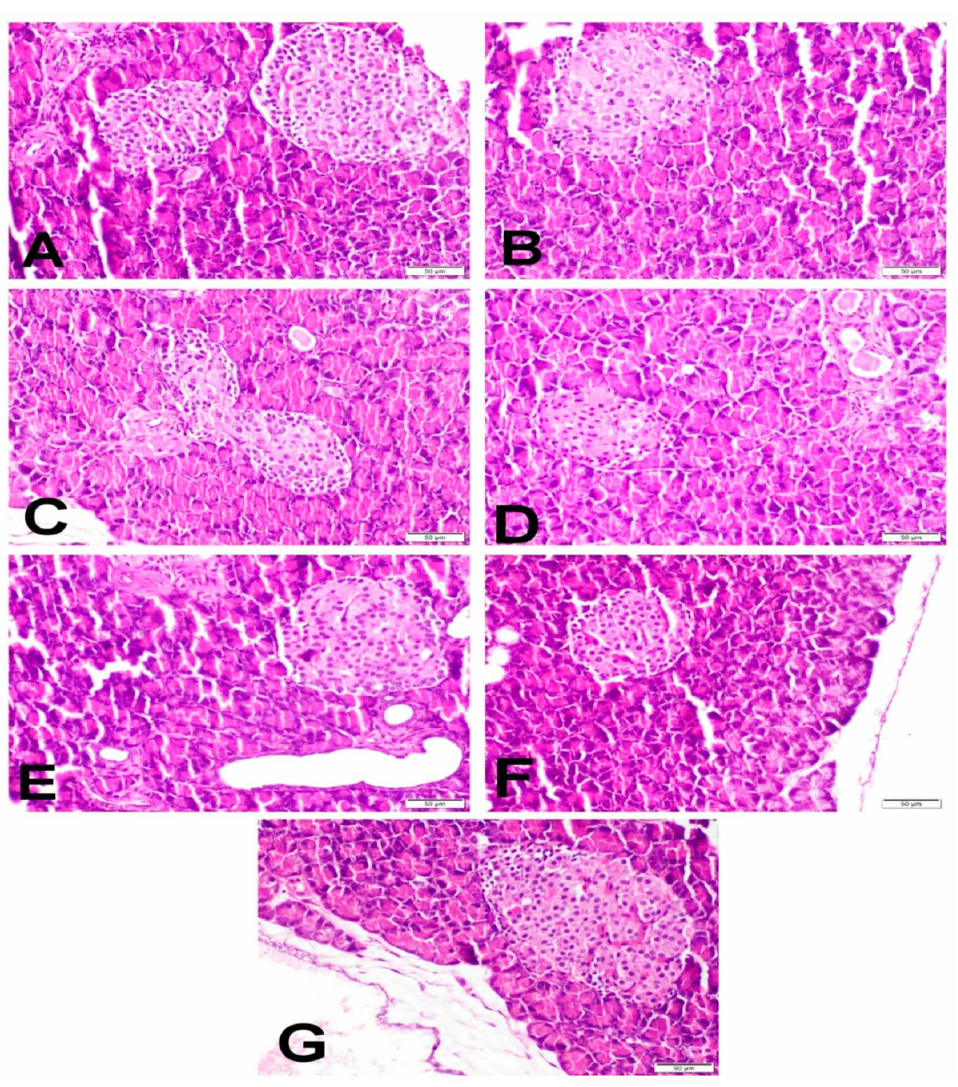
Figure 2. The histopathological photomicrographs of the pancreases in all experimental groups: ( A ) NC group showing normal islets composition; ( B ) STZ-control group showing marked reduction in the number, necrosis and apoptosis of β -cells and distortion of the islet’s composition; ( C , D ) GLB and VGN-10 showing mild reduction in the number of β -cells; ( E – G ) VGN-20, GLB+VGN-10 and GLB+VGN-20 showing marked improvement of the β -cells number with single cell